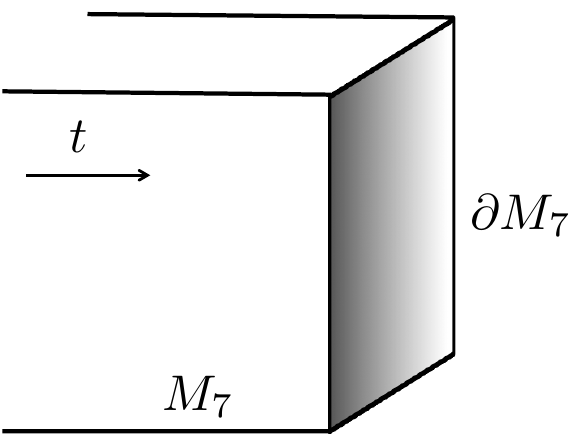
Figure 1 . A representation of the bulk-boundary geometry considered in this paper. We denote the 7D bulk by M 7 , the 6D boundary by @M 7 and time running into the boundary by t . that these membranes are the genuine microscopic degrees of freedom for the 7D system.